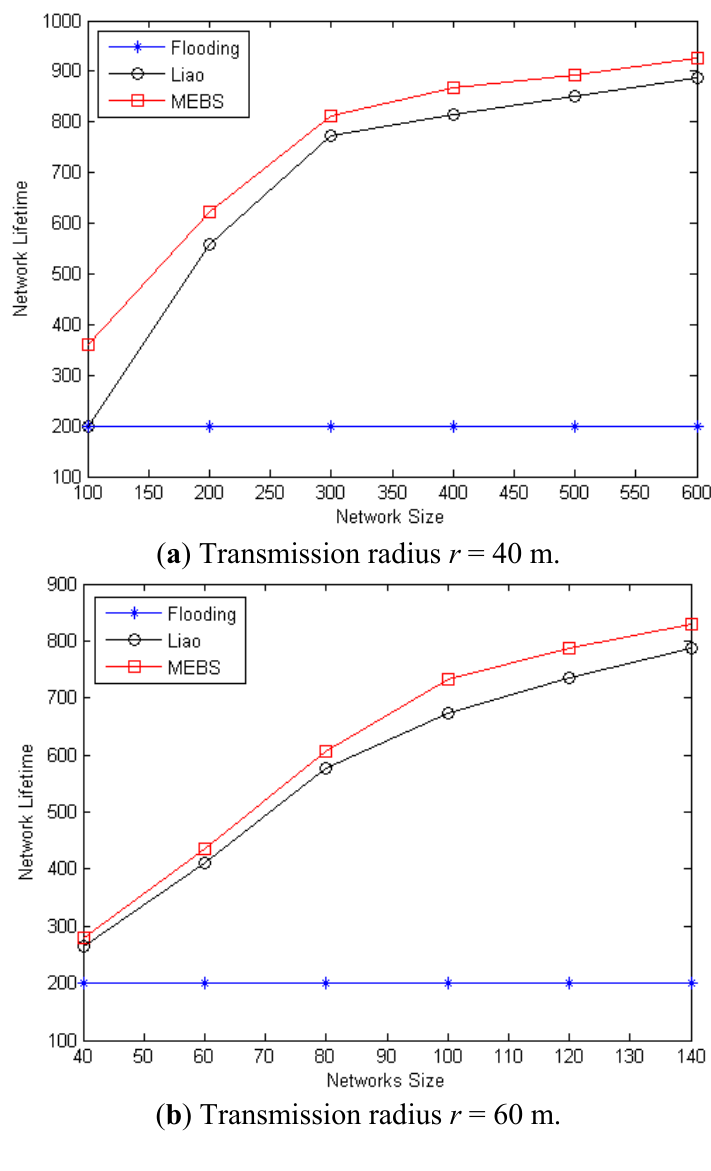
Figure 12. Network lifetime with different number of nodes. ( a ) Transmission radius r = 40 m; ( b ) Transmission radius r = 60 m.